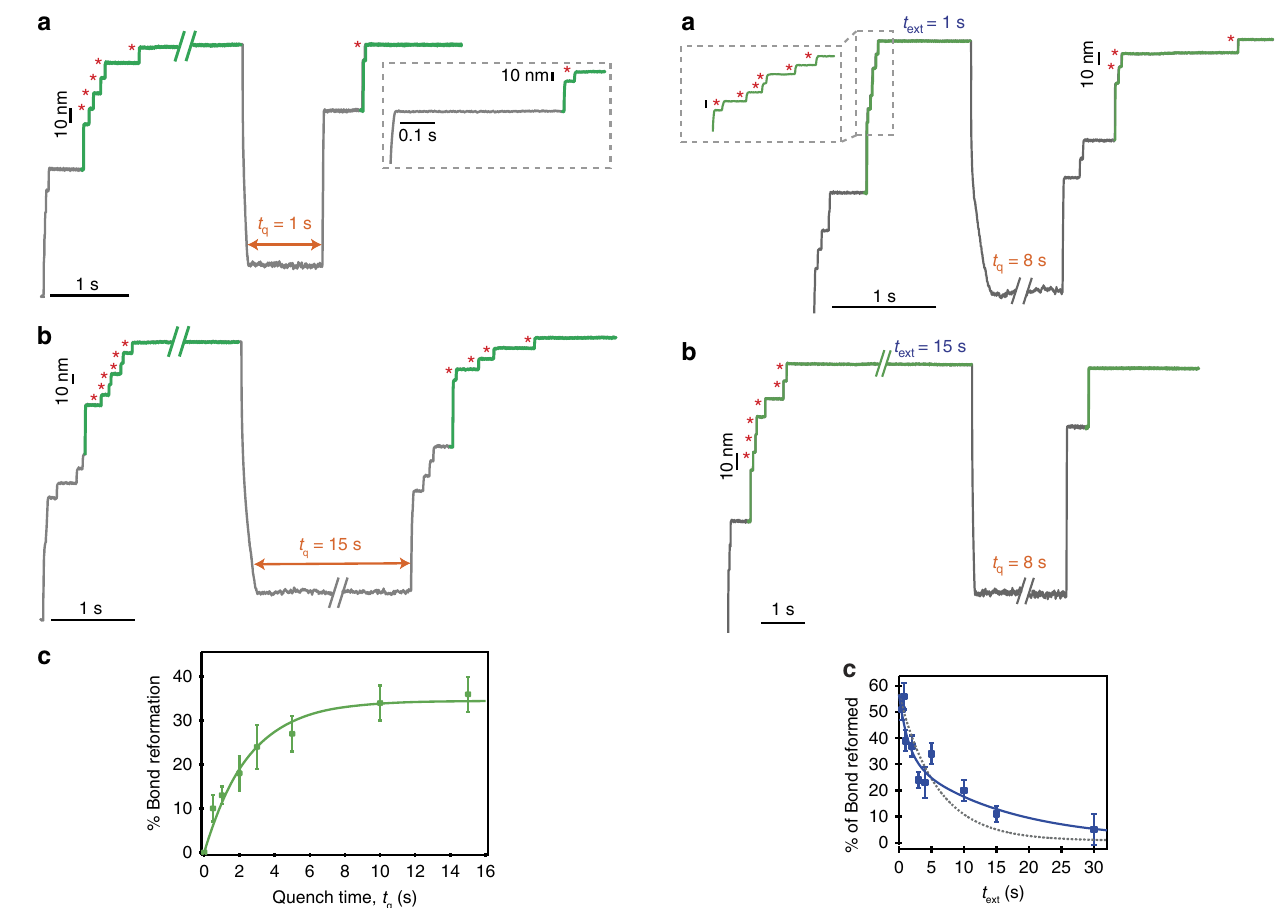
Figure 3 | S -sulfenylation of cryptic cysteines inhibits oxidative folding. ( a , b ) Increasing the time, t ext , the protein is reduced and stretched at high force ( F ¼ 500pN) results in a drastic decrease of successful oxidative folding (marked by the decrease of both B 10nm steps, red asterisks, and B 15nm steps in the test pulse). ( c ) While the decrease in the % of disulfide bond reformation as a function of t ext can be fitted with a single exponential (dotted grey line) with a rate constant k ¼ 0.17s (cid:2) 1 ( w 2 red ¼ 5.02), the trend is best described ( w 2 red ¼ 2.78) by a double exponential fit (solid blue line), with associated rate constants k 1 ¼ 0.065s (cid:2) 1 and k 2 ¼ 0.695s (cid:2) 1 , reminiscent of two competing processes occurring